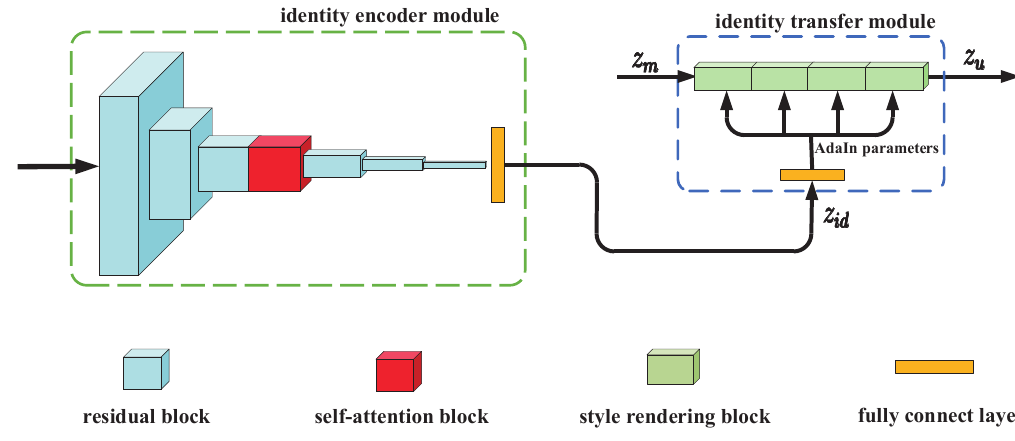
Figure 2. The identity encoder and identity transfer